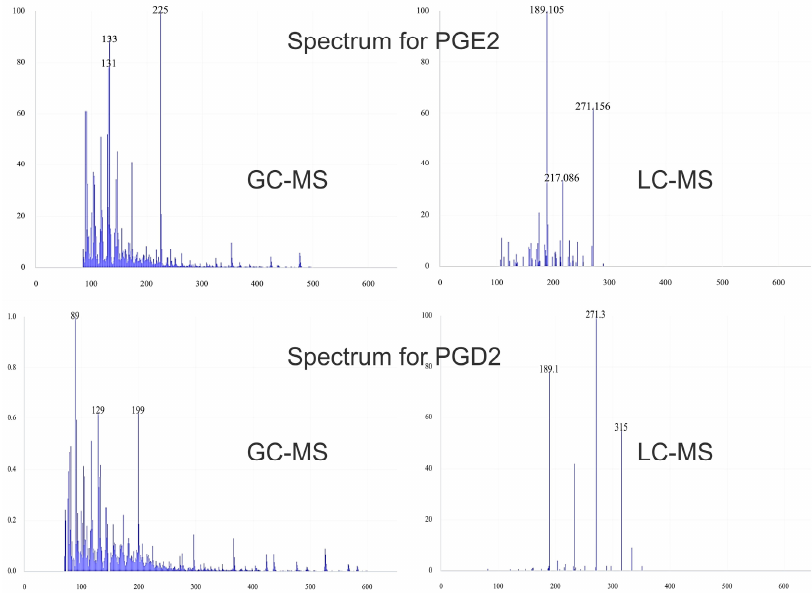
Figure 1. Representative mass spectra of prostaglandin E2 (PGE2) and prostaglandin D2 (PGD2) obtained by using hard (gas chromatography–mass spectrometry (GC–MS)) and soft ionization (liquid chromatography–mass spectrometry (LC–MS)/MS) in spectrometry mass.